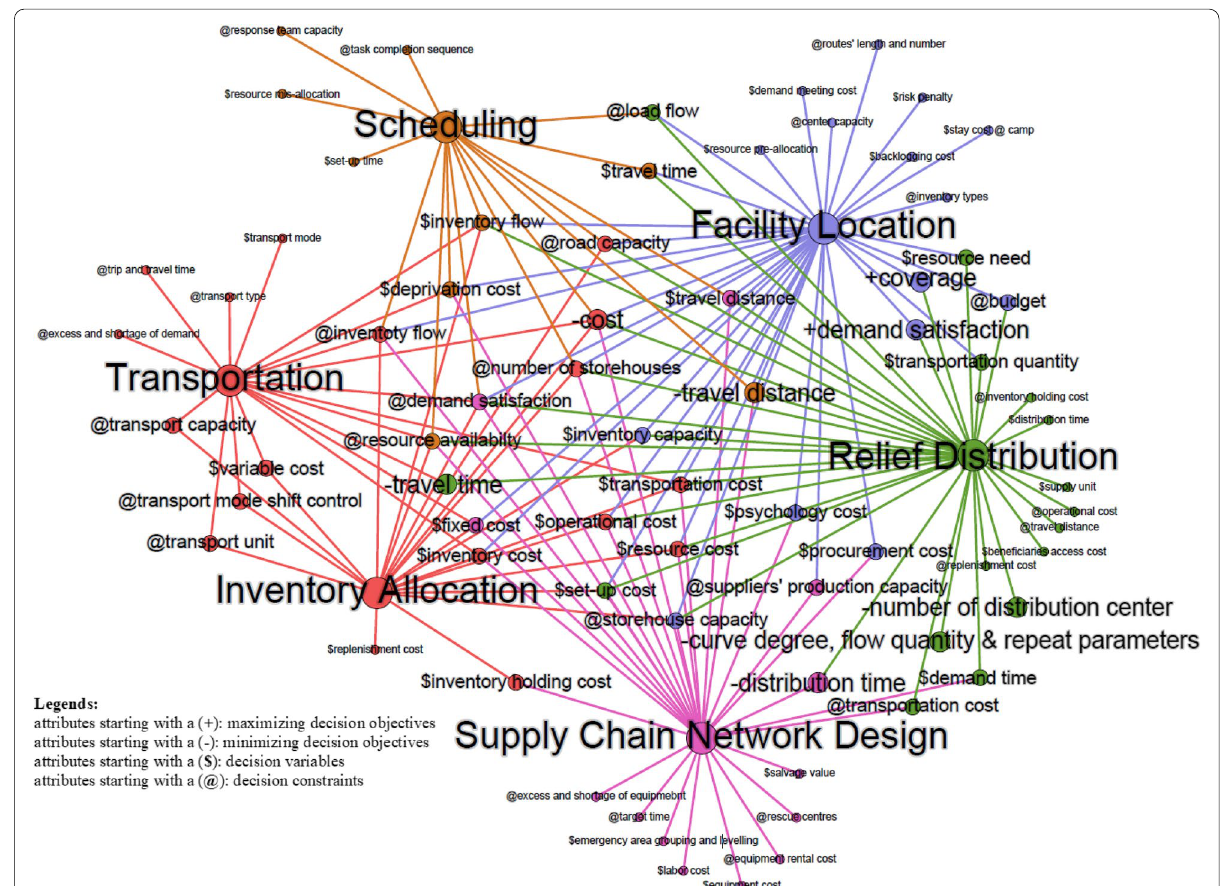
Fig. 4 Interconnectedness between problem areas based on common decision factors